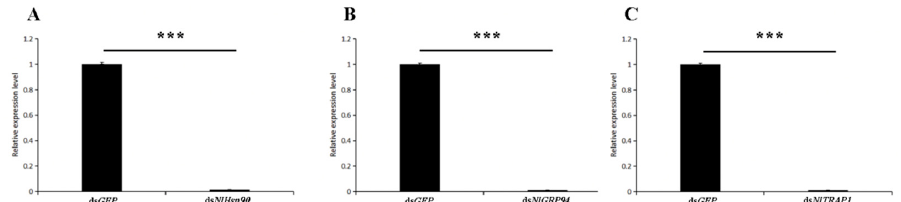
Figure 4. Transcript levels of N. lugens Hsp90s (( A ). NlHsp90 , ( B ). NlTRP94 and ( C ). NlTRAP1 ) after double-stranded RNA injection. Three days after injection, 6 to 8 insects were collected randomly to evaluate the RNAi efficiency. RT-qPCR and the 2 - ΔΔ Ct method were used to measure the relative transcript levels. The results are presented as the mean ± SEM. *** p < 0.001 (Student’s t -test). Bars represent the SEM derived from three independent biological replicates.